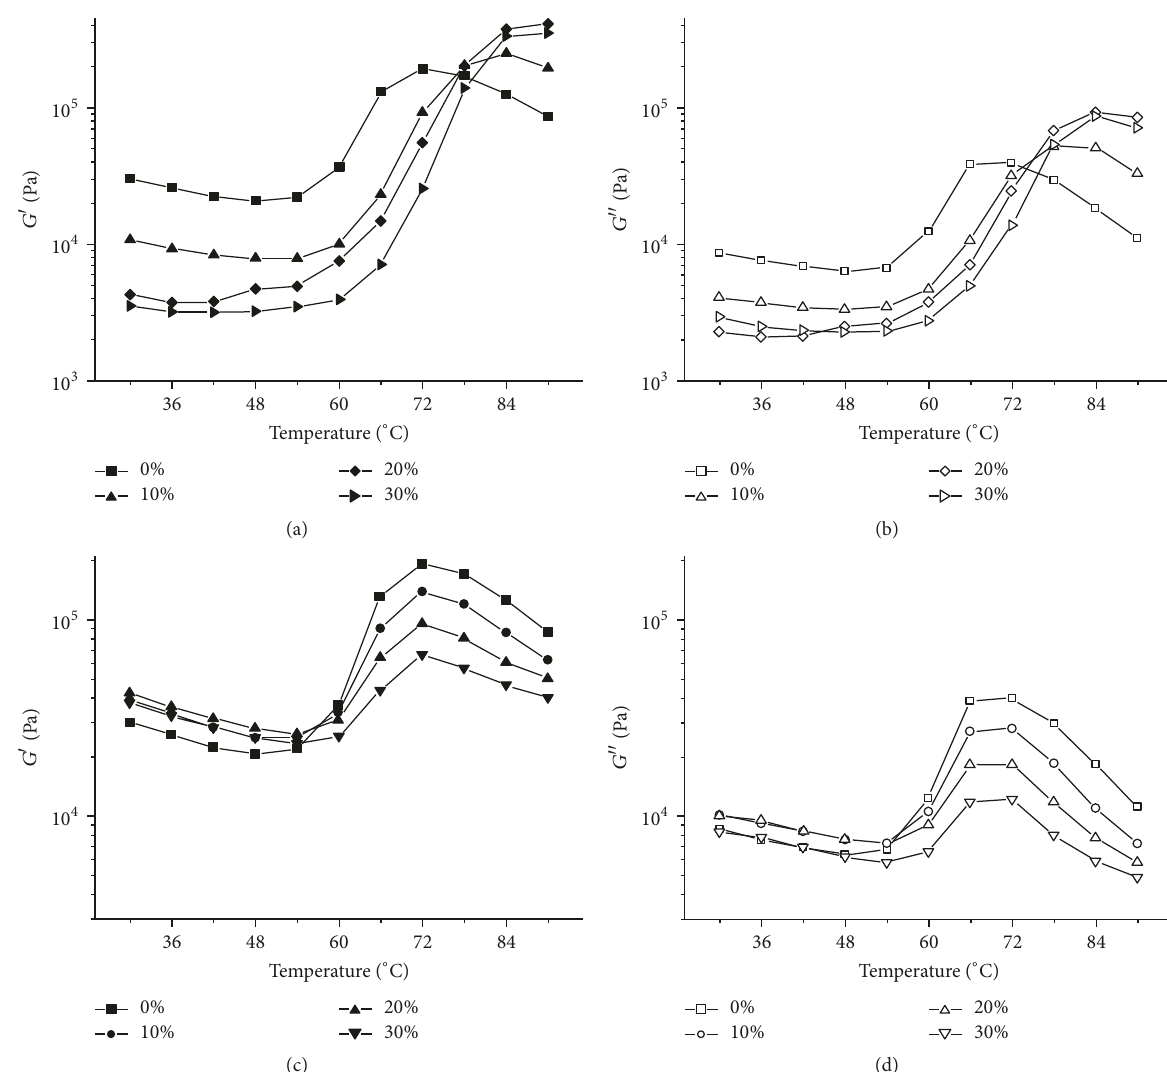
Figure 2: The effect of whey and soy protein addition on 𝐺 󸀠 and 𝐺 󸀠󸀠 of wheat dough with temperature sweep: WP ((a), (b)); SP ((c), (d)).